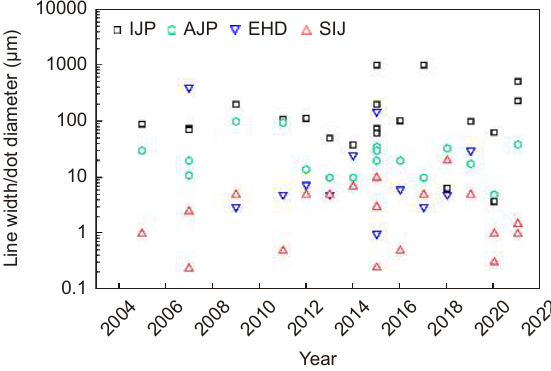
Fig. 7 | A distribution of line widths of various inkjet printing in recent decades 16–19,42–44,48,50,52–115 .